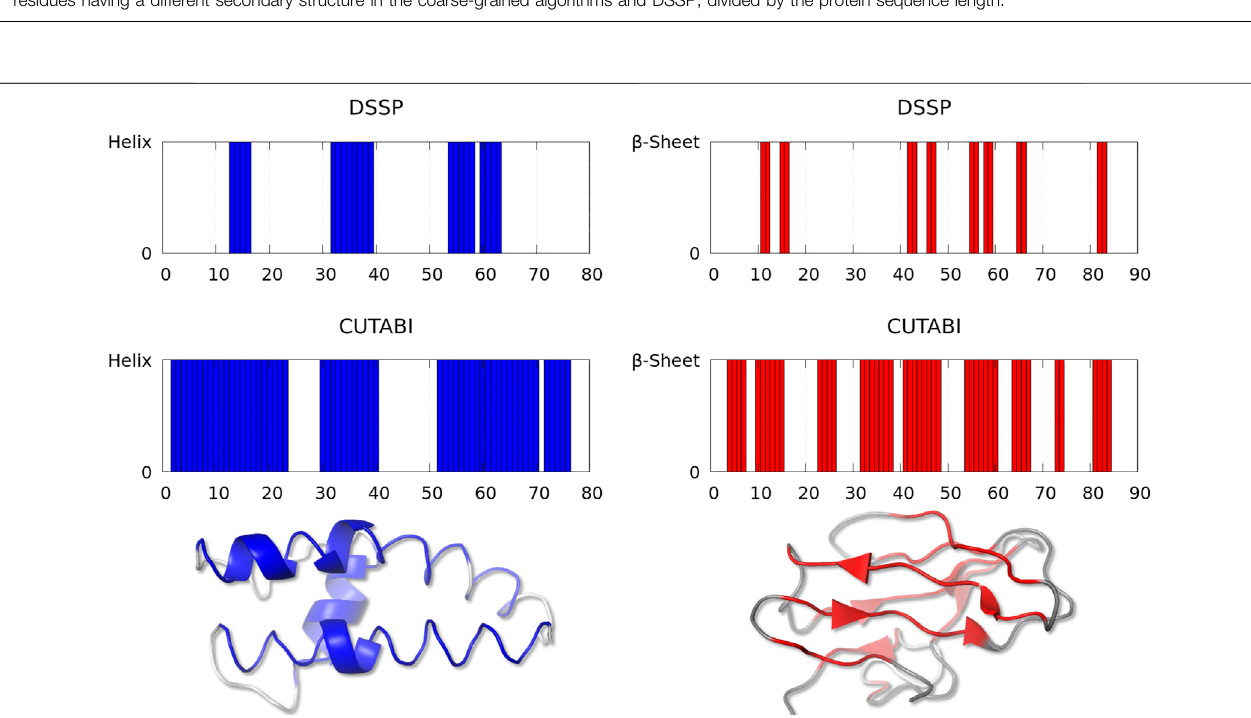
FIGURE3| Representativestructures withalargediscrepancybetweentheSSE assignmentbyDSSPandCUTABIforthehelix(left,ASTRALID: d1lnqa2)and for the β -sheet (right, ASTRAL ID: d1eh9a1). In the left (right) panel, each blue (red) bar represents a residue pertaining to the helix (to the β -sheet). The 3D main chain is representedwithablue(red)tubeforresiduespertainingtothehelix(tothe β -sheet)forCUTABIand withablue(red) cartoonforDSSP.Residuesnotinthehelix orinthe β -sheet are in gray. The 3D representations were made with the PyMOL software (Schrödinger, 2015).